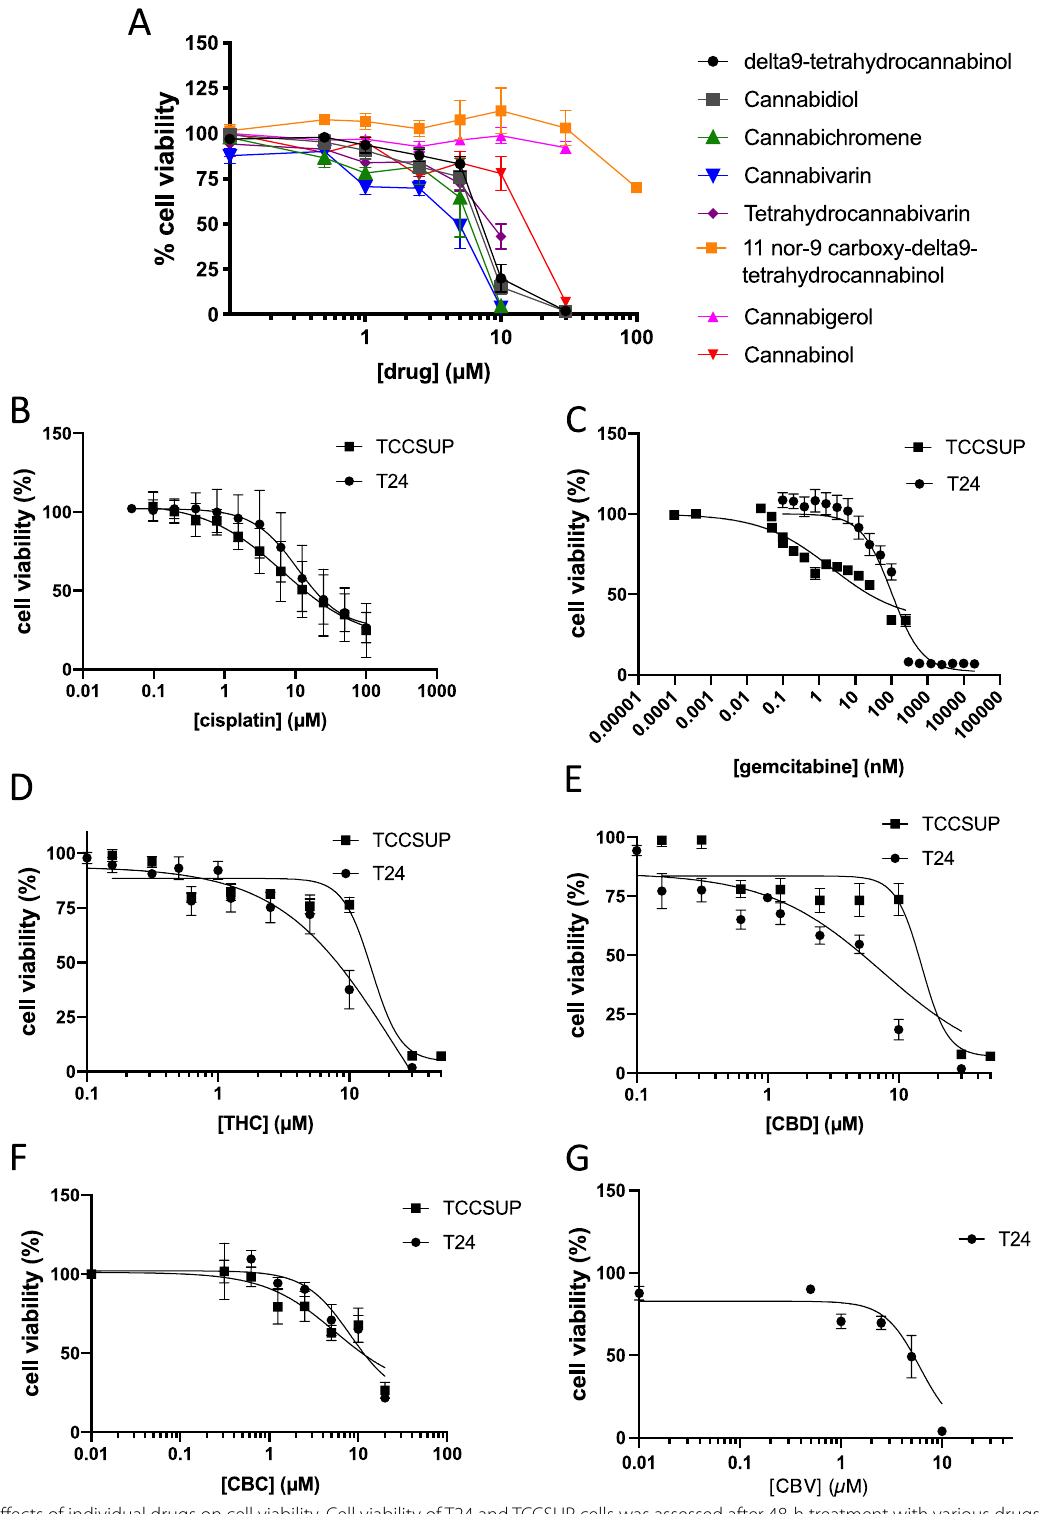
Fig. 1 Effects of individual drugs on cell viability. Cell viability of T24 and TCCSUP cells was assessed after 48-h treatment with various drugs in a concentration-response experiment. A All cannabinoids tested in the study in T24 cells are compared in the same graph. B Cisplatin alone. C Gemcitabine alone. D Δ 9 -Tetrahydrocannabinol alone. E Cannabidiol alone. F Cannabichromene alone. G Cannabivarin alone, in the indicated cell lines. Results are means SEM of at least 3 independent ±